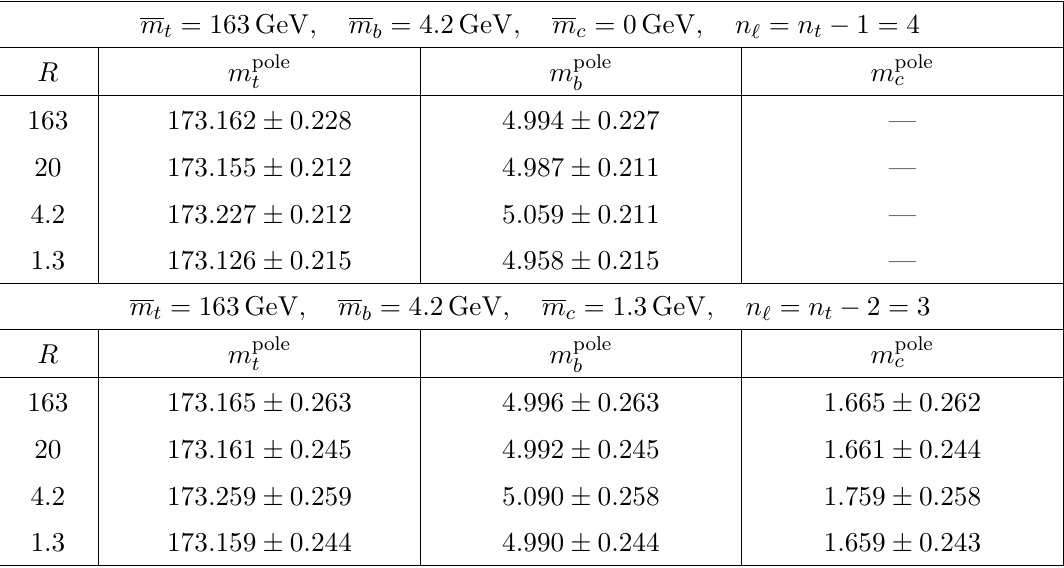
( m t ; m b ; m c ) = (163 ; 4 : 2 ; 0) GeV for R = 163 ; 20 ; 4 : 2 ; 1 : 3 GeV. Lower section: best estimate